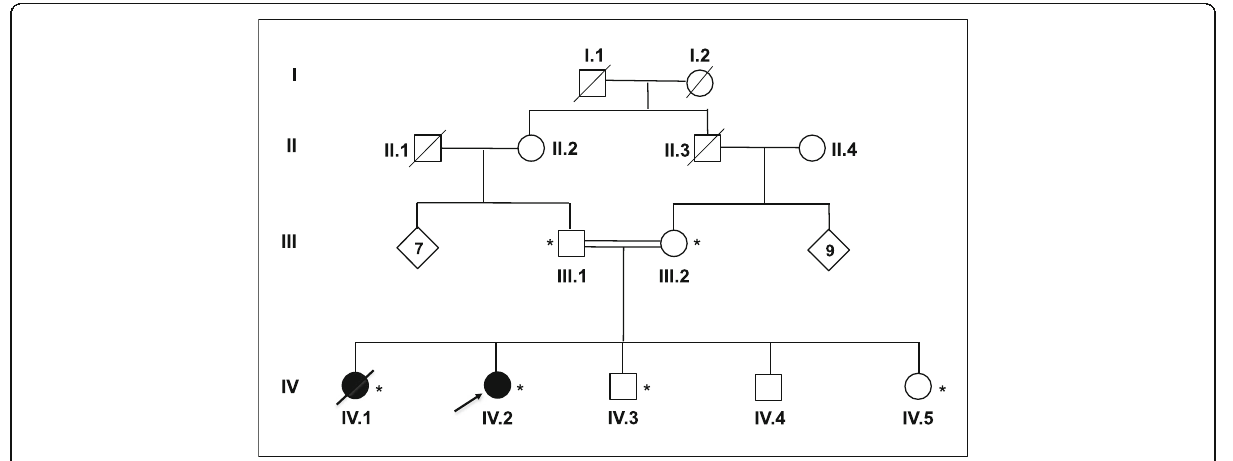
Fig. 1 Pedigree of a consanguineous Moroccan family with ChAc. Arrow: index patient. Asterisk: genetic testing